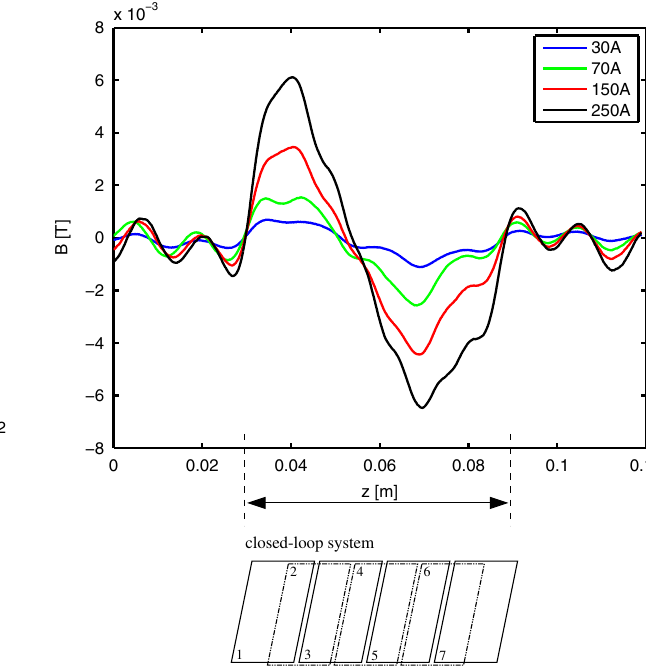
FIG. 6. (Color) Difference of the field measurements with and without the YBCO loops system. The YBCO loop system tries to compensate the field which increases from left to right in Fig. 2.